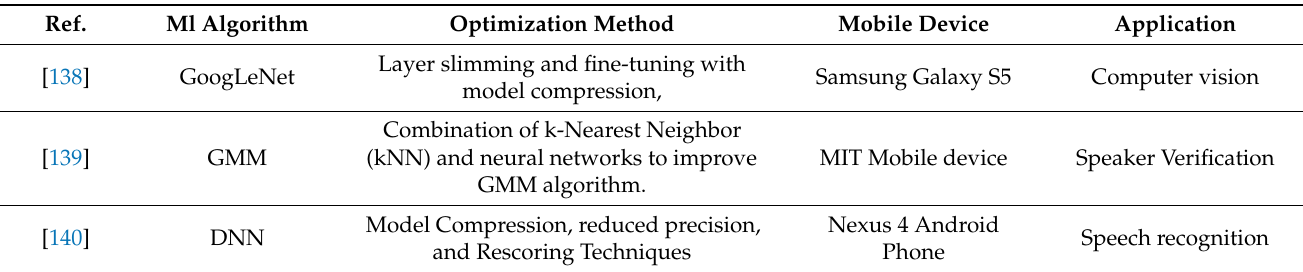
Table 14. Some literature on mobile machine